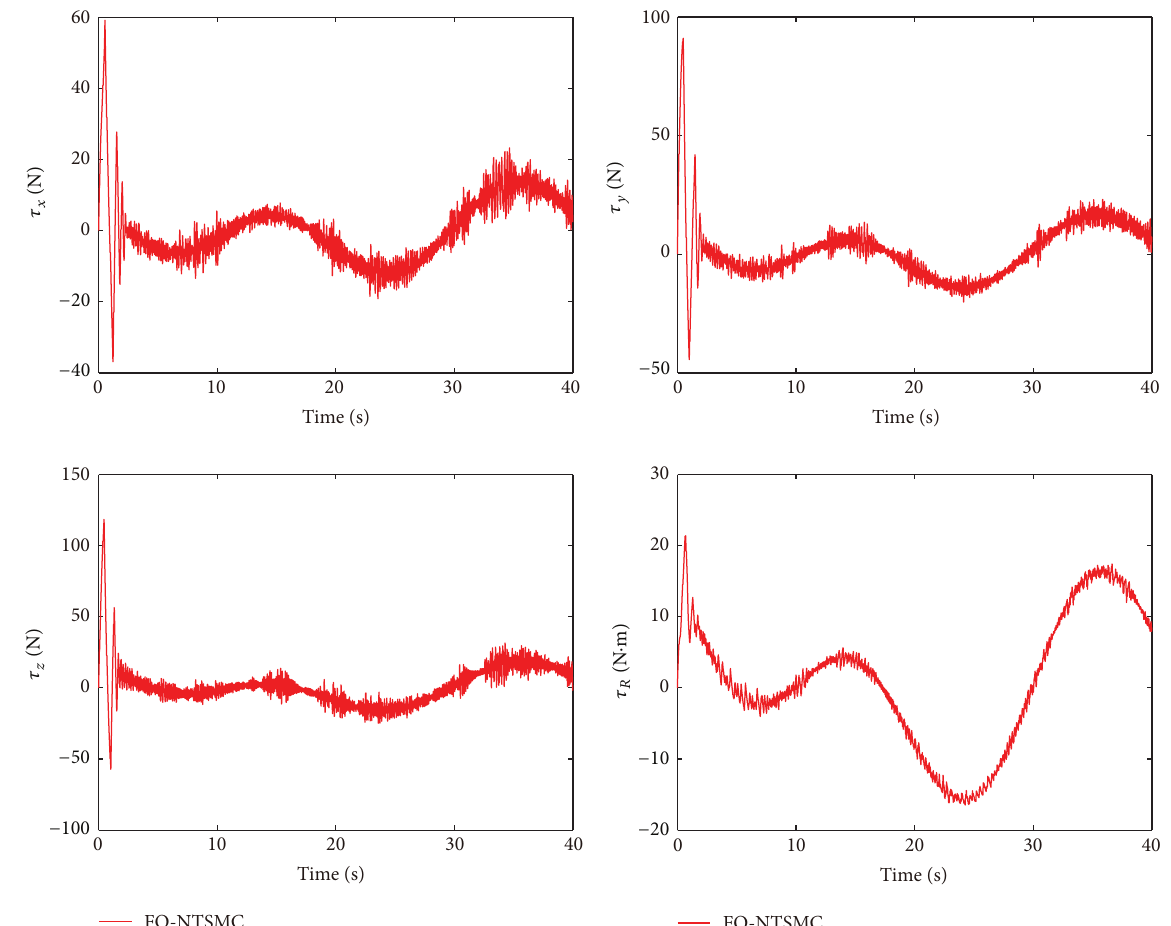
Figure 8: Control inputs of output feedback